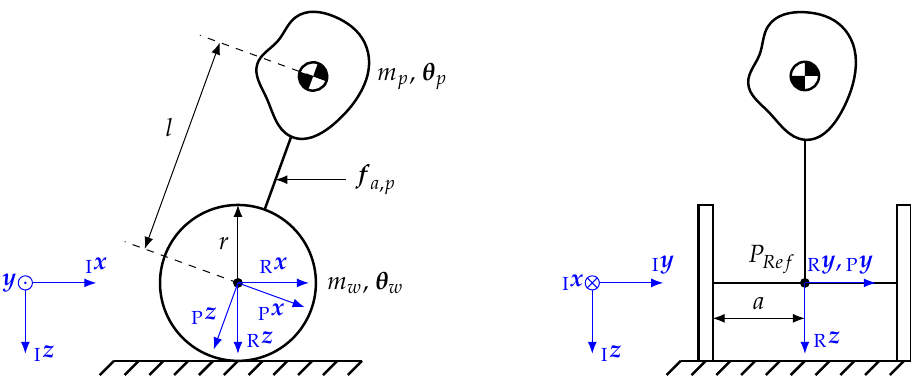
Figure 22. Schematic of the segway model with a heading ψ =